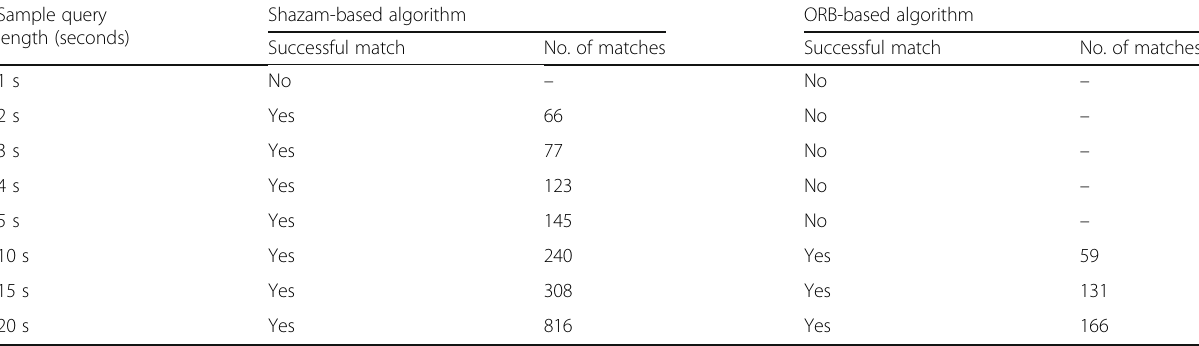
Table 4 Test for granularity of Shazam and ORB prototypes Sample query length